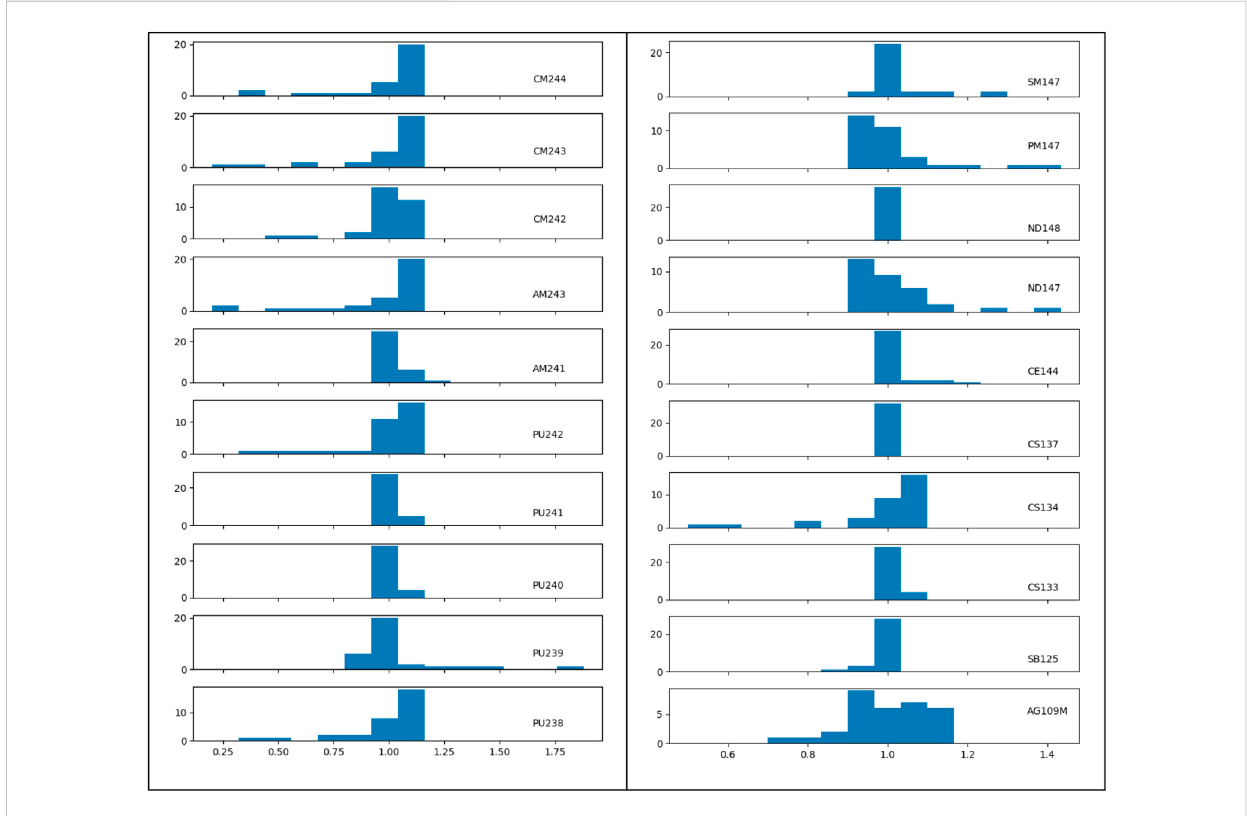
FIGURE 6 Nuclide vector spread for a representative PWR UO 2 fuel assembly at 50MWd/kg; isotopic concentrations are normalized to burnup of each axial node of the active zone (i.e., if nuclide concentration would scale linearly with burnup all values would be at